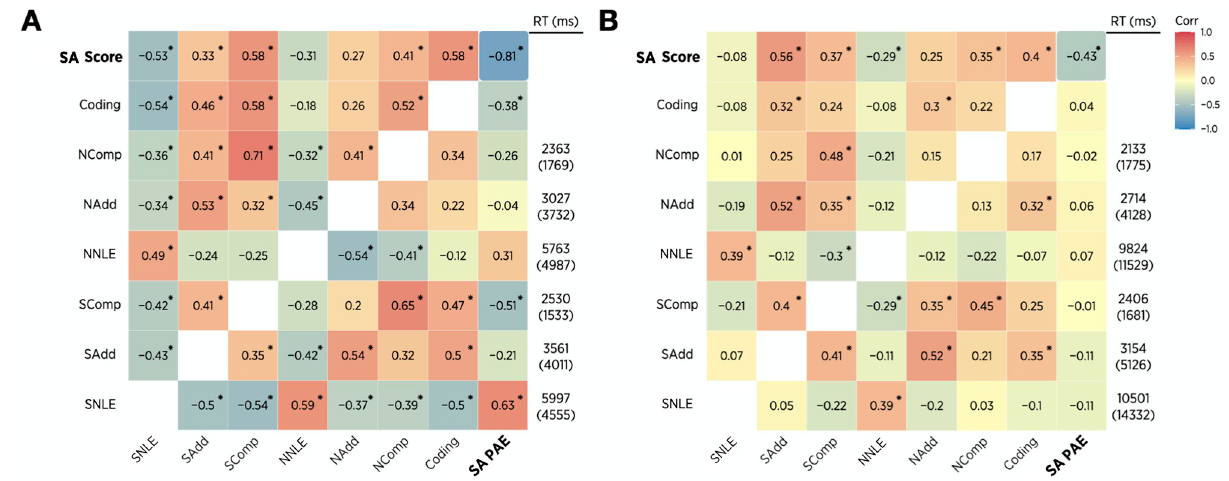
Fig 4. Means and standard deviations (in parenthesis) of reaction times and correlations among symbolic arithmetic (SA) scores and PAEs, accuracy of coding, and accuracy of numerical magnitude tasks in US (A) and Chinese (B) children. NComp represents non-symbolic comparison, NAdd non-symbolic approximate addition, NNLE non-symbolic number-line estimation, SComp symbolic comparison, SAdd symbolic approximate addition, and SNLE symbolic number-line estimation. For number-line estimation tasks, percent absolute errors were used as an accuracy measure. Correlation coefficients on the upper diagonal were computed using data after removing outliers based on arithmetic scores (n = 93), whereas those on the lower diagonal were from data with outlier exclusion by symbolic arithmetic PAEs (n = 87). � indicates p < .05.